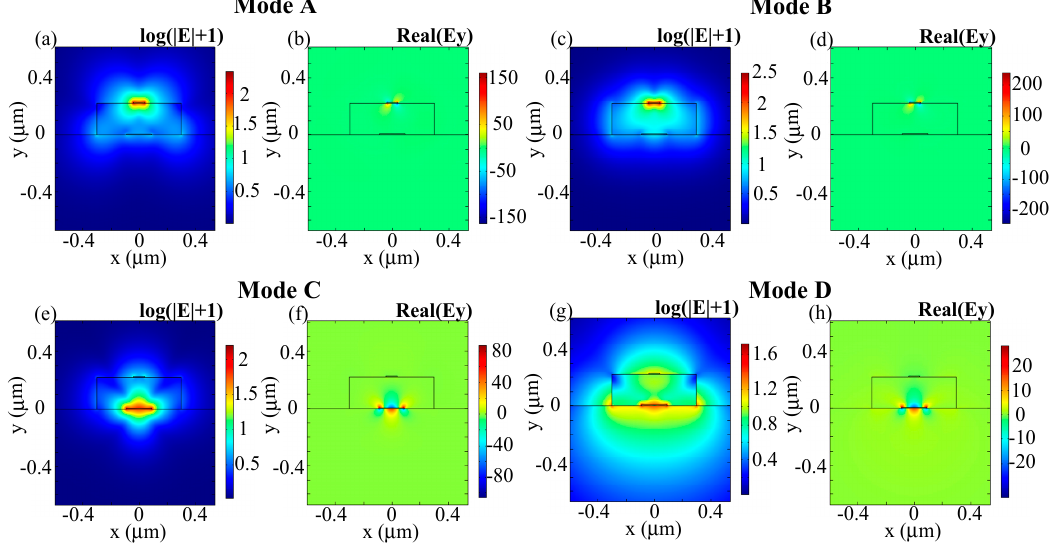
Figure 4. Electric field profiles of the hybrid modes: ( a , b ) mode A; ( c , d ) mode B; ( e , f ) mode C; and ( g , h ) mode D when w t = 0.08 µm, w b = 0.18 µm; (a,c,e,g) log(|E| + 1), (b,d,f,h) real(E y ). Other parameters: Au, h m = 6 nm, λ = 1.55 µm, h si = 220 nm, w si = 600 nm.